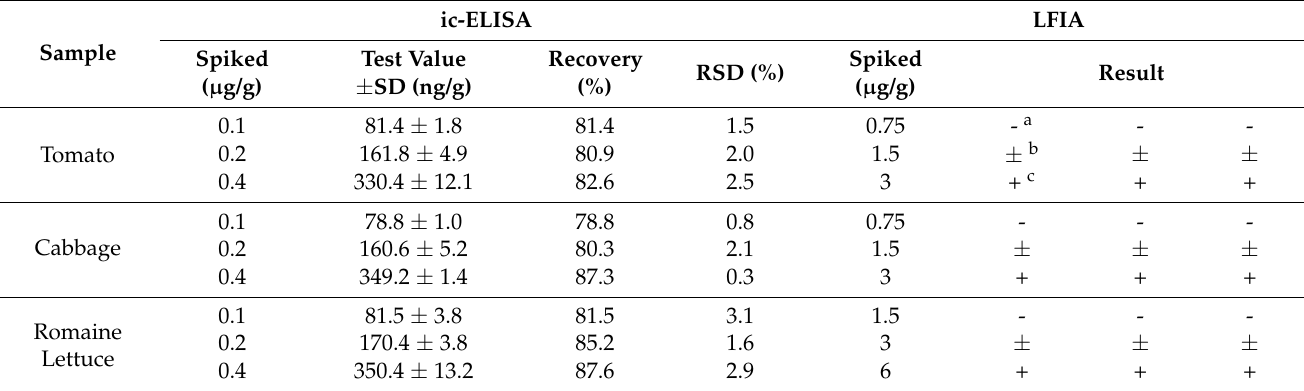
Table 2. Recovery of CYP in the spiked samples by ic-ELISA and LFIA ( n = 3).